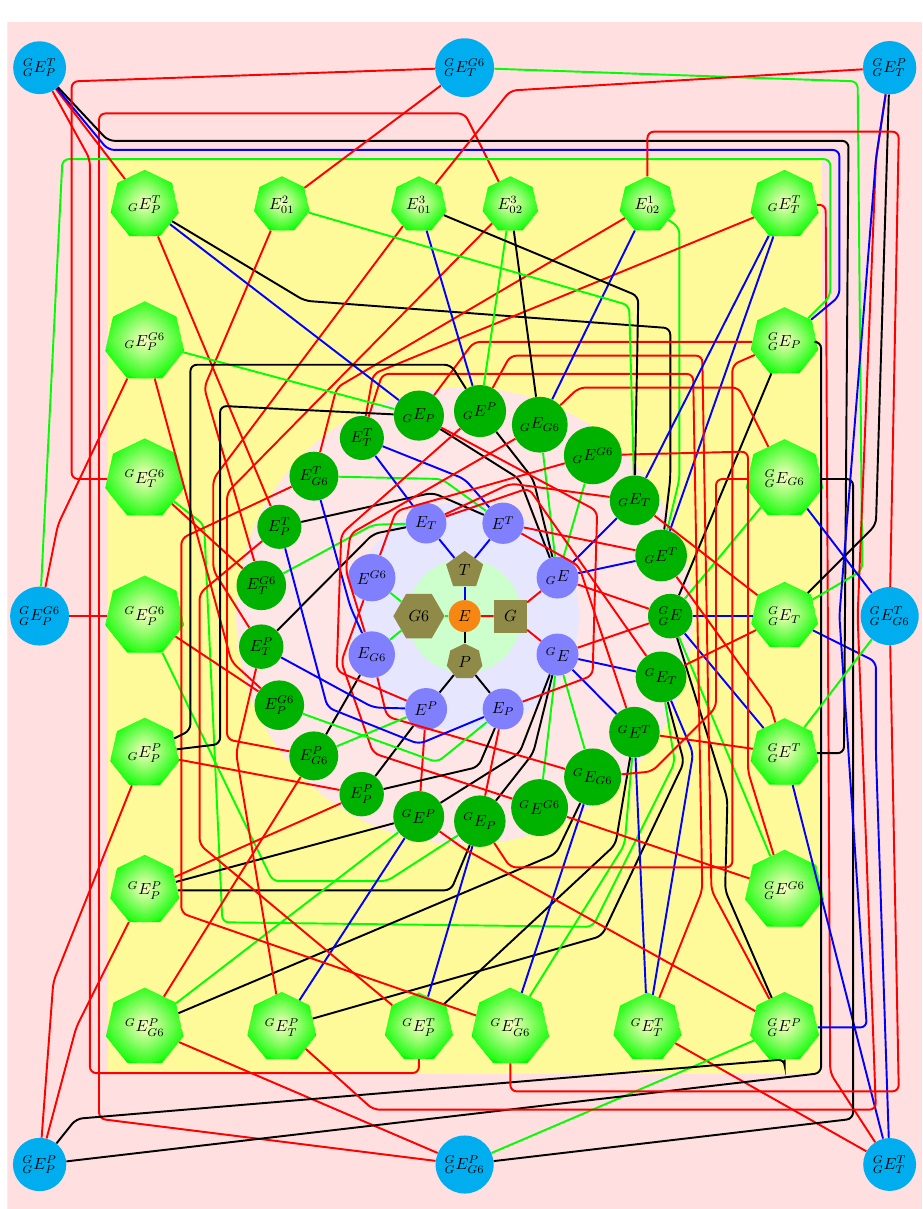
Figure 7. Diagram of chemical reactions forming all complexes in the mixture. E , 0, 1, 2, and 3 represent the free enzyme, glucose, ATP , G 6 P , and P i molecules, respectively. The red lines refer to reversible reactions involving glucose binding; the blue: ATP binding; the green: G 6 P binding; the brown: P i binding. Letters E with a superscript(s) and/or subscript(s) denote complexes of the enzyme, for instance E 01 is a complex of the enzyme with one glucose and one ATP molecule bound 3 at the N -binding site, and one P i molecule bound at the C -binding